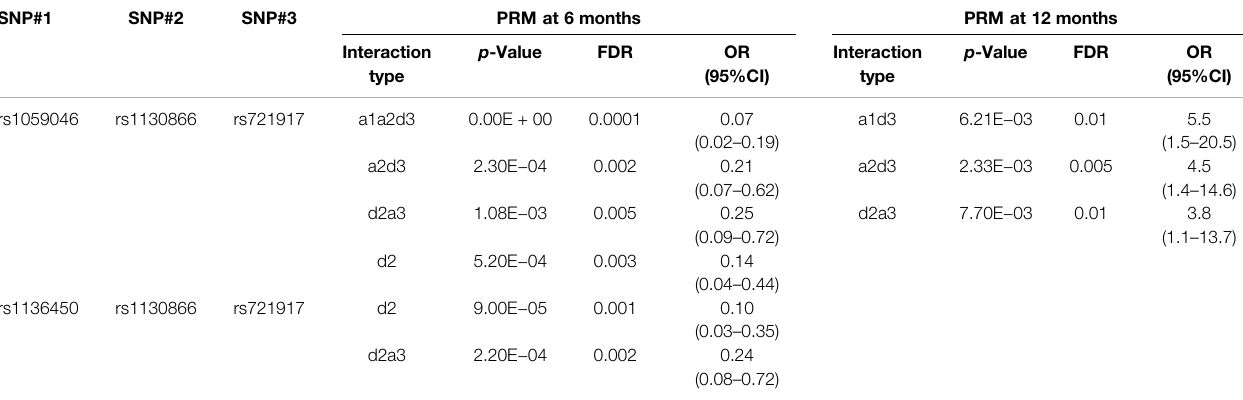
TABLE 6 | Association ofSPgeneSNP interactions withpersistent respiratorymorbidity (PRM)at 6 and 12 months in athree-SNPmodel after adjusting forcovariates (age, sex, race, and weight).